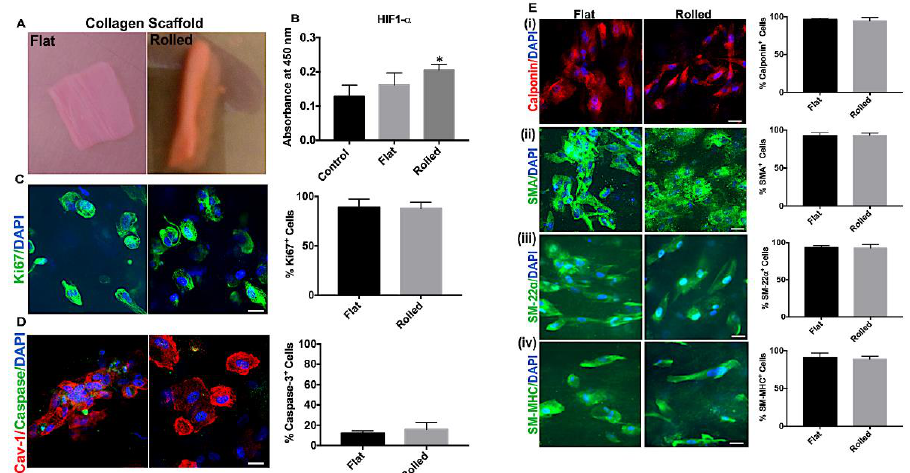
Figure 2. A dense fibrillar collagen (DC) scaffold in rolled configuration produces a hypoxic environment and maintains cell viability and morphology of hiPSC-VSMCs. Type I collagen was used to build DC scaffolds of flat and rolled configuration. The hiPSC-VSMCs embedded were characterized for cell viability and phenotype. ( A ) Gross images of flat and rolled scaffold embedding hiPSC-VSMCs in culture. The scaffolds were in the rolled configuration for 72 h to create a hypoxic environment. ( B ) Qualitative ELISA analysis showing the expression of HIF-1α in the flat and rolled cellular scaffolds. The cellular hydrated collagen (4 mg/mL) and flat scaffolds were used as a control ( n = 8, Rolled vs. Control p < 0.0001; Rolled vs. Flat p < 0.03; Flat vs. Control p > 0.05). ( C ) Ki67 immuno-stained flat and rolled scaffolds and the graph representing % Ki67 positive cells after three days of culture ( n = 4, p > 0.05). ( D ) Caspase-3 immuno-stained flat and rolled sca ff olds and the graph representing % caspase-3 positive cells after three days of culture ( n = 4, p > 0.05). Caveolin-1 was used to stain the cell membrane and dapi for nuclei. Phenotype characterization of hiPSC-VSMCs cultured in flat and rolled configuration for three days were performed by immunostaining with major VSMC markers ( Ei ) calponin ( n = 4, p > 0.05), ( Eii ) SMA ( n = 4, p > 0.05), ( Eiii ) SM-22 α ( n = 4, p > 0.05), and ( Eiv ) SM-MHC ( n = 4, p > 0.05). Dapi was used to stain nuclei. Scale bar measures 50 µ m. Statistical analysis was performed using one-way ANOVA and student t -test. * denotes statistical